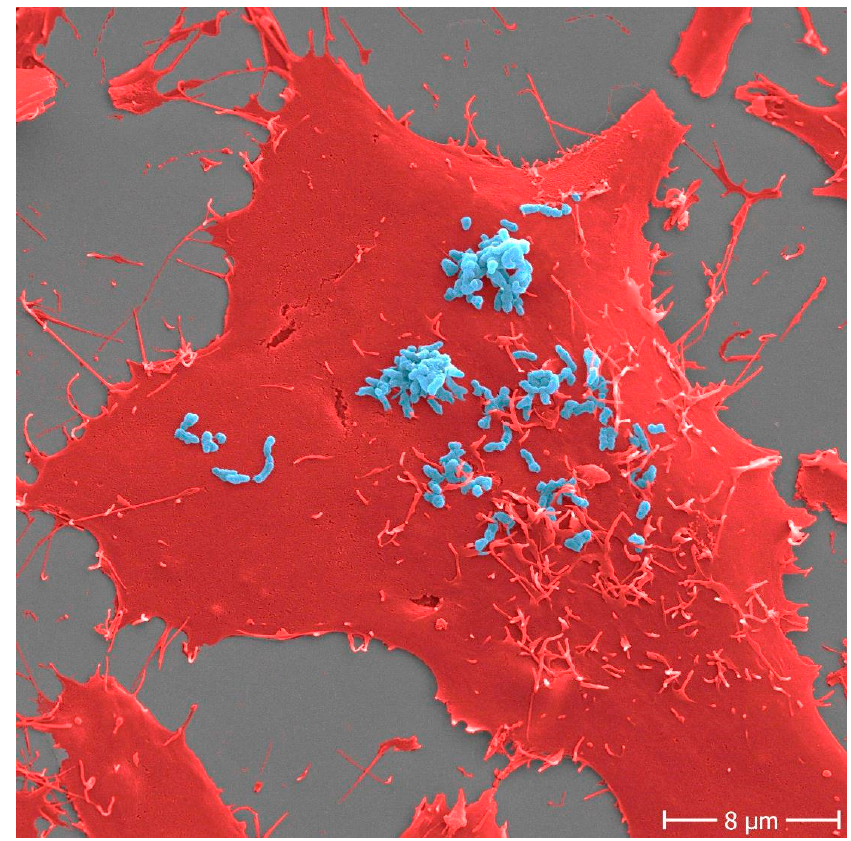
Figure 1. Adhesion of Bartonella henselae to human cells. B. henselae (strain Marseille) bacteria (light blue) in an early stage infection process (30 min) to human HeLa-229 cells (red). Adhesion to host cells is mediated by specific interactions between B. henselae surface proteins and components of the host extracellular matrix including molecules such as fibronectin or collagen. Scale bar: 8 µ